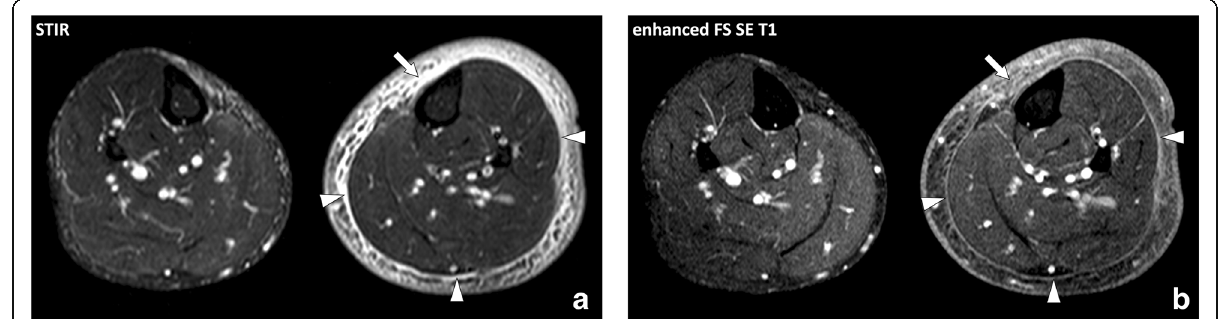
Fig. 7 Axial ( a ) STIR and ( b ) contrast-enhanced fat-suppressed SE T1w images of the legs of a 55-year-old male with non-complicated cellulitis of the left leg. MRI demonstrates diffuse thickening of the subcutaneous soft tissues with increased fluid content infiltration of the fascia superficialis enhancing after contrast material injection, more severe on the antero-medial part of the leg (arrow). Note the inflammatory infiltration along the interface between the hypodermis and the deep peripheral fascia which conserve normal thickness and signal (arrowheads)